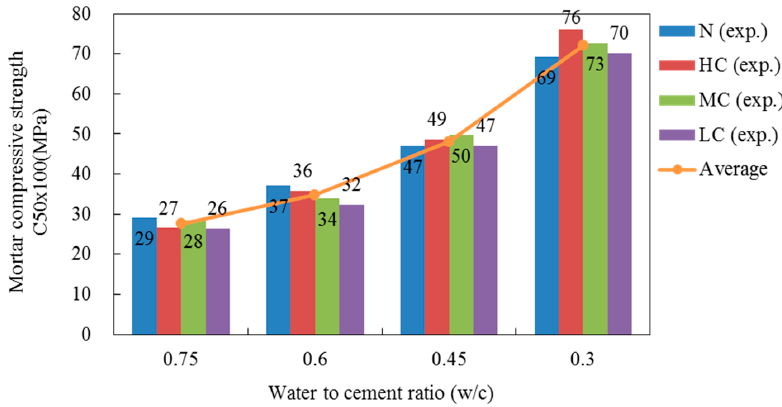
Figure 8. Compressive strength of mortar with different water-to-cement ratios.